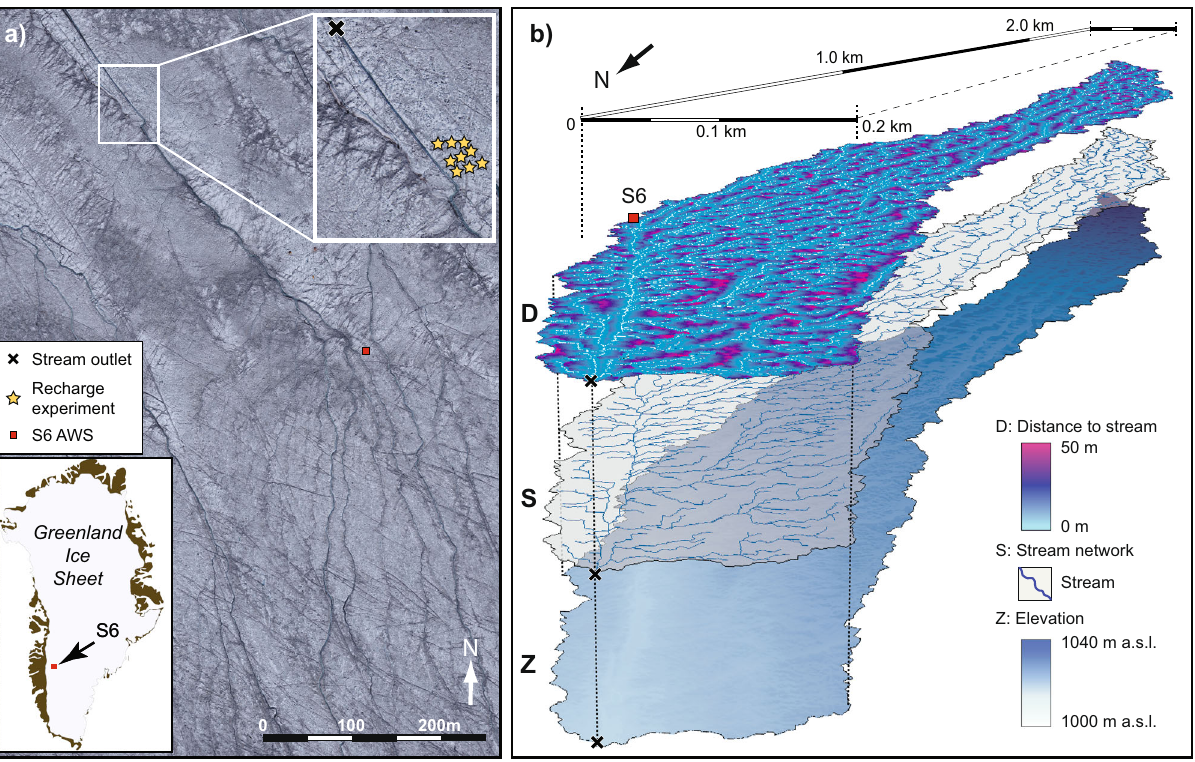
Fig. 1 The S6 study site on the western margin of the Greenland Ice Sheet. a High resolution unmanned aerial vehicle (UAV) derived digital red-green- blue (RGB) colour imagery of the ice sheet surface proximate to the S6 automatic weather station (AWS) to provide context to the bail-recharge experiments and experimental catchment outlet point (upper inset). b Staggered perspective maps of the study catchment topography (Z), the associated stream network (S), and fl ow-distance-to-stream metric